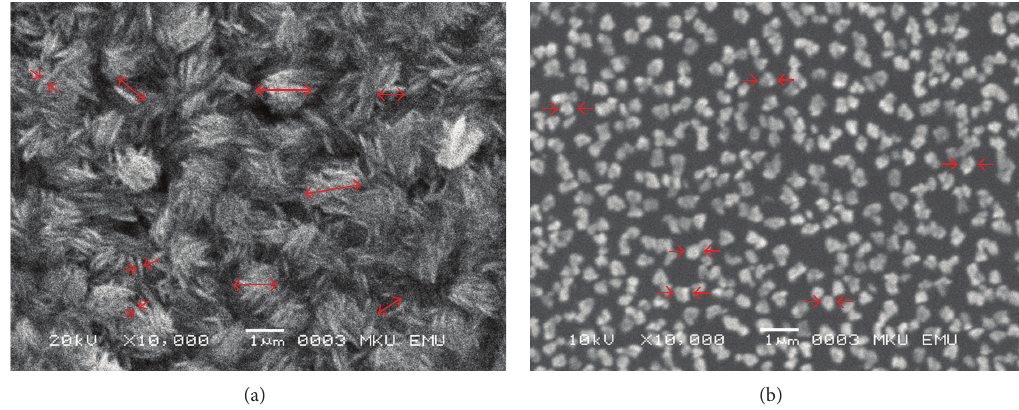
Figure 1: SEM images of the CuO films growth by the (a) CBD method and (b) sol-gel method.